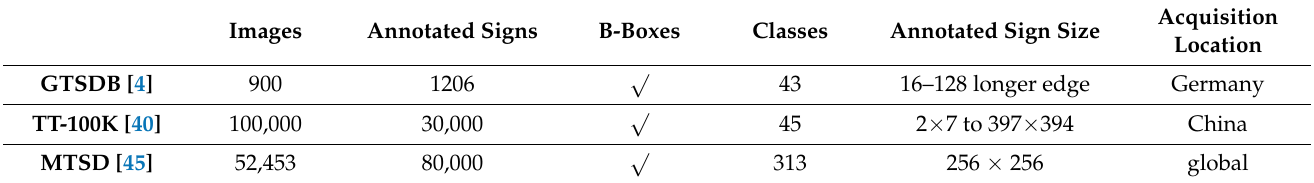
Table 1. Main characteristics available in TSD